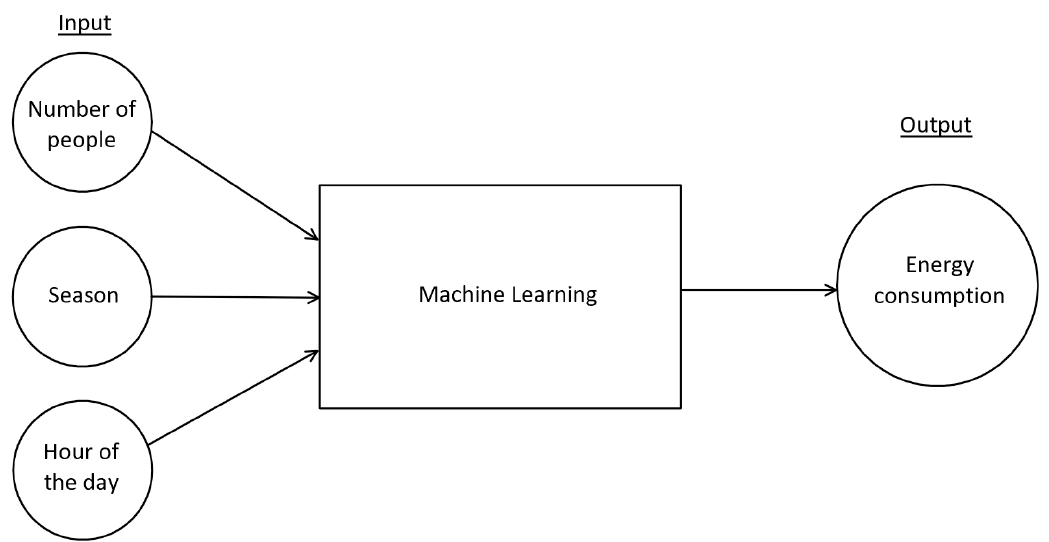
Figure 5. Data-flow of machine learning with the input and output choices. Hidden layers are the layers of neurons in between the input layer and the output